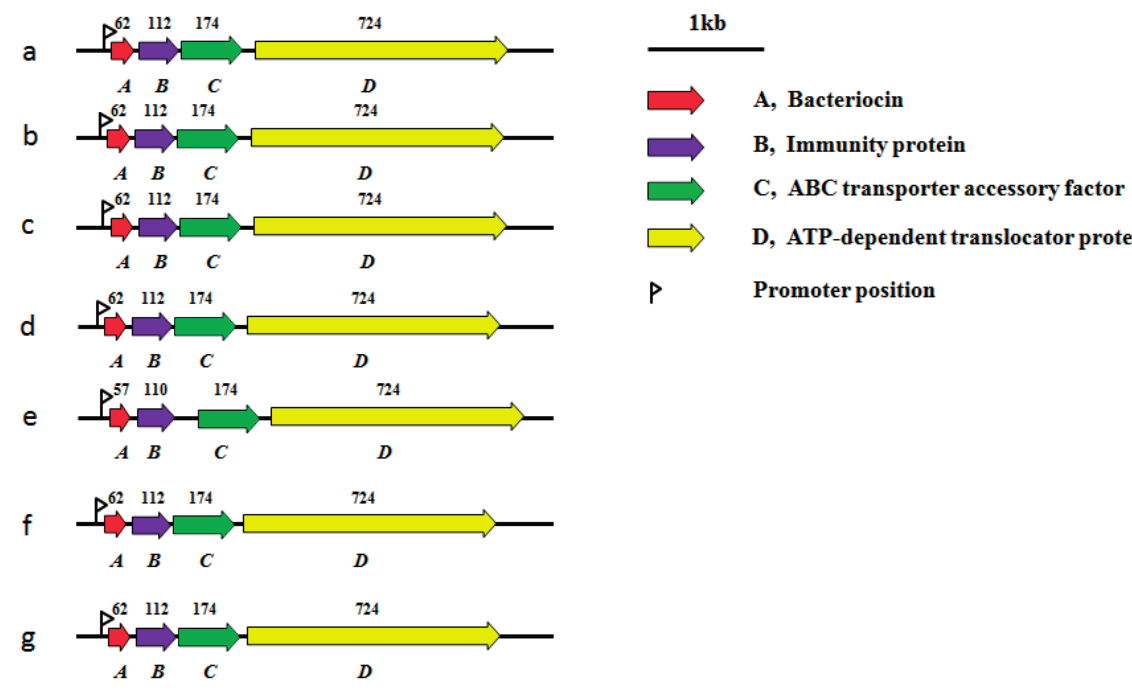
Figure 2. Organization of the gene clusters of pediocin and related bacteriocins from different plasmids. ( a ) pS34 from P. pentosaceus ( Pediococcus pentosaceus ) S34 (NG_035883.1); ( b ) pATO77 from P. parvulus ( Pediococcus parvulus ) ATO77 (NG_035882.1); ( c ) pSMB74 from P. acidilactici ( Pediococcus acidilactici ) H (NC_004832.1); ( d ) pWHE92 from L. plantarum WHE92 (NG_035884.1); ( e ) pPLA4 from L. plantarum 423 (AF304384.2); ( f ) pI4 from B. coagulans I 4 (NG_035346.1); and ( g ) pEnt4 from E. faecium